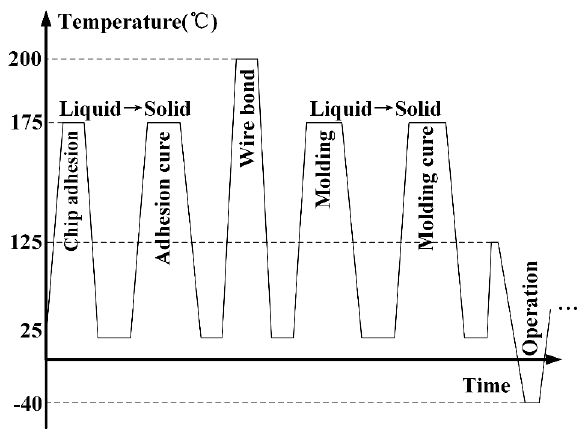
Figure 7. Typical temperature variation during sensor chip packaging, redrawn from [67].